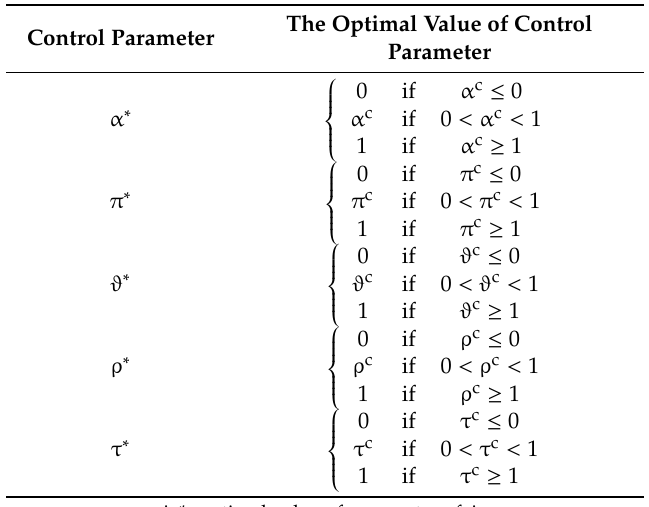
Table 4. The optimal control parameter of each strategy.